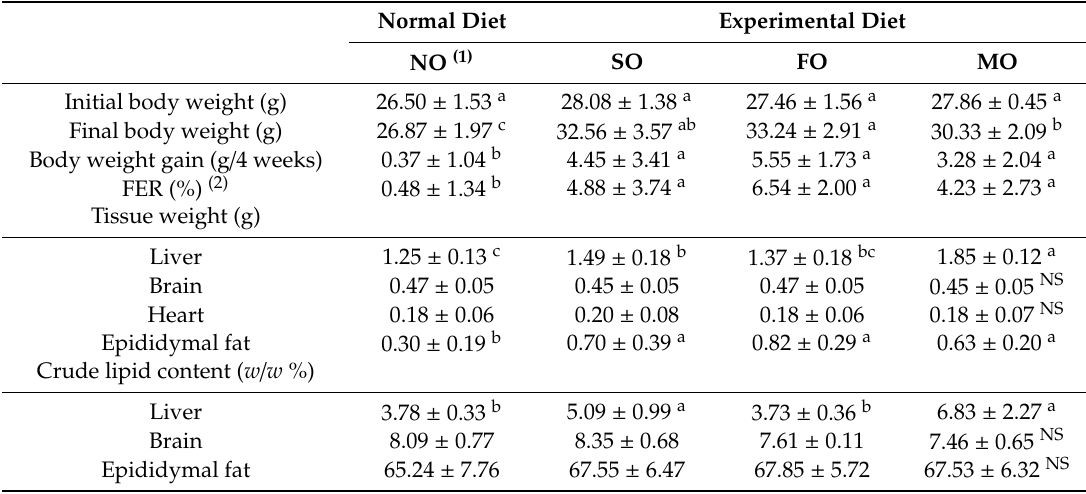
Table 2. E ff ect of experimental diet on body weight, tissue weight, and crude lipid content in tissues of